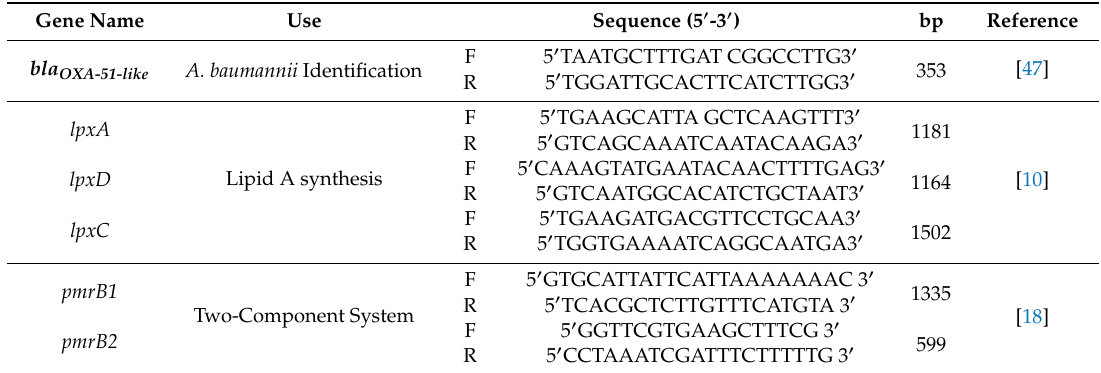
Table 4. Primers used in this